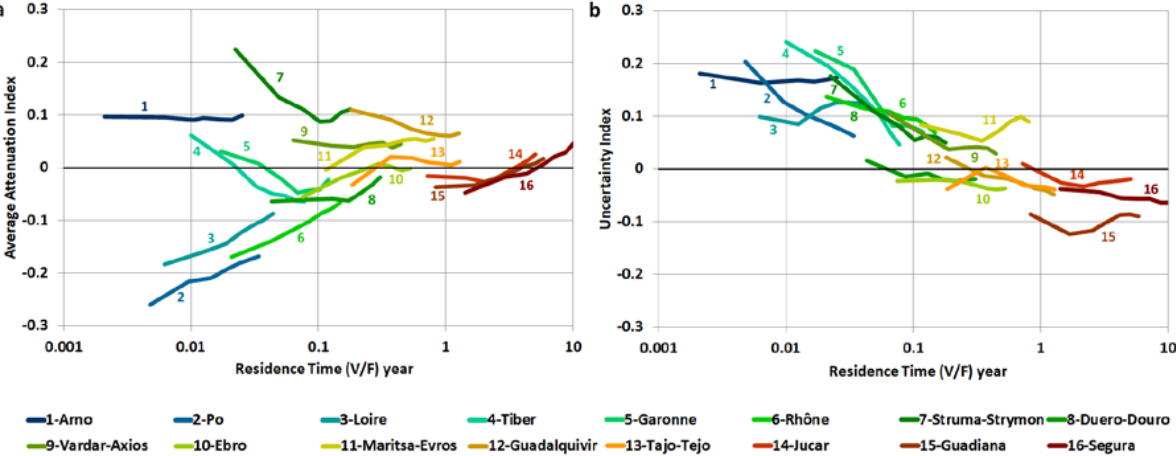
Figure 12. Comparison of the values of average I A index and I U index obtained in the sensitivity analyses of reservoir storage in the 16 basins under study. ( a ) Average value of the attenuation index (I A ) for the 35 available projections as a function of reservoir storage. ( b ) Value of the uncertainty index ( I U ) as a function of reservoir storage.